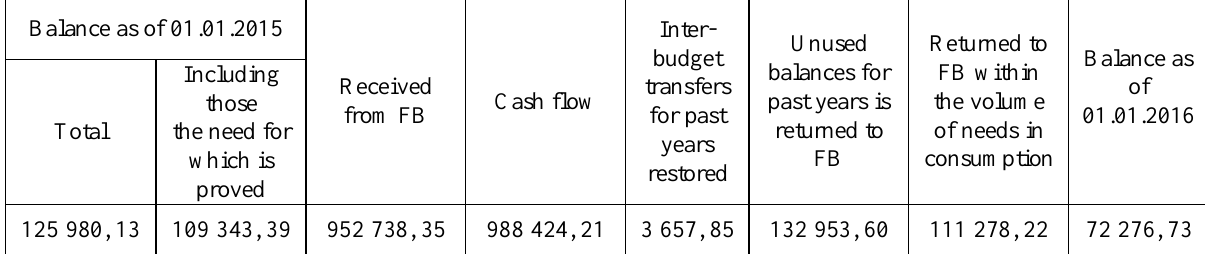
Table 5. Provision of inter-budget transfers to budgets of RF subjects in 2015 by the federal budget, in mln rubles Balance as of